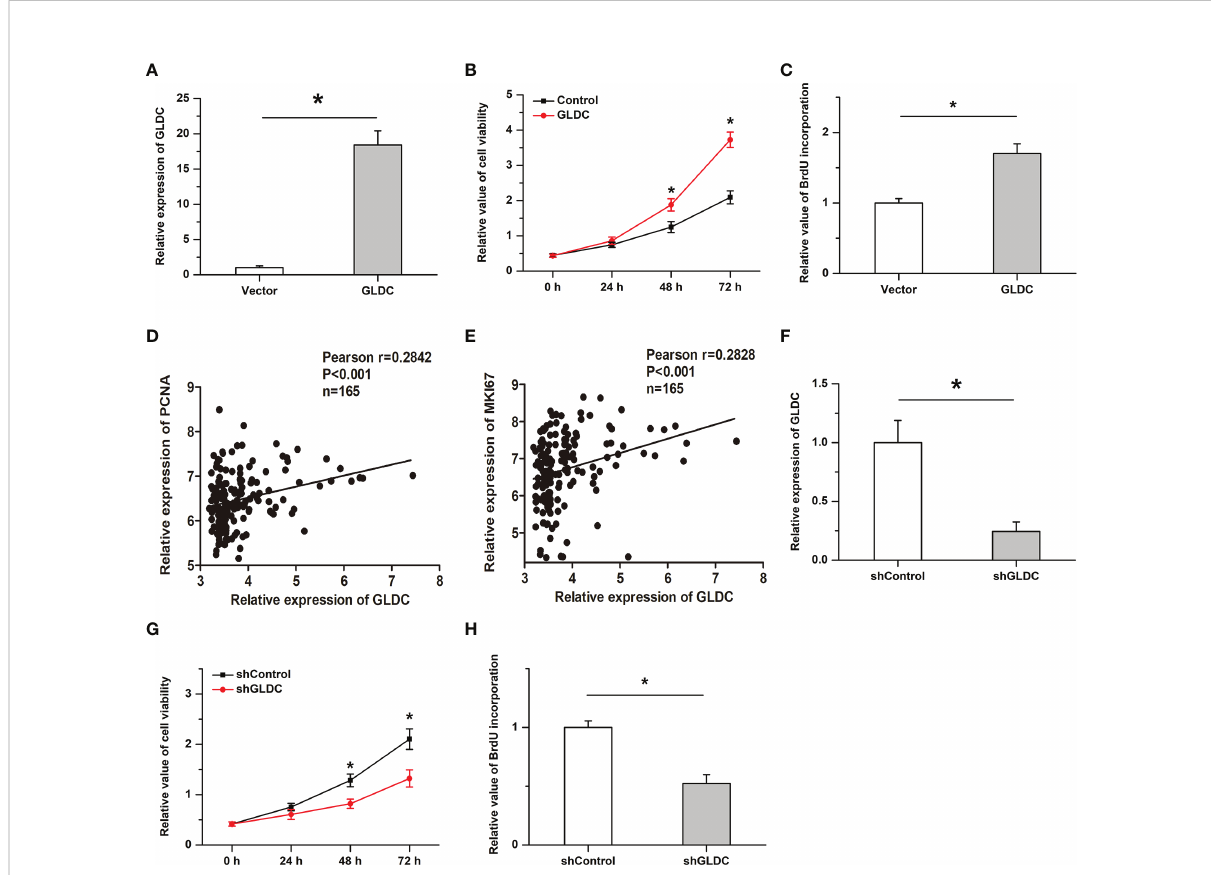
FIGURE 4 Cell proliferation is promoted by GLDC in TNBC cells. (A) Real-time PCR was utilized to determine the overexpression ef fi ciency. (B, C) Overexpression of GLDC increased cell viability (B) and facilitated BrdU incorporation (C) . (D, E) GLDC expression was positively correlated with the expression of PCNA (D) and MKI67 (E) in TNBC tissues. (F) Knockdown ef fi ciency was determined by Real-time PCR. (G, H) Knockdown of GLDC mitigated cell viability (G) and repressed BrdU incorporation (H) . *P <